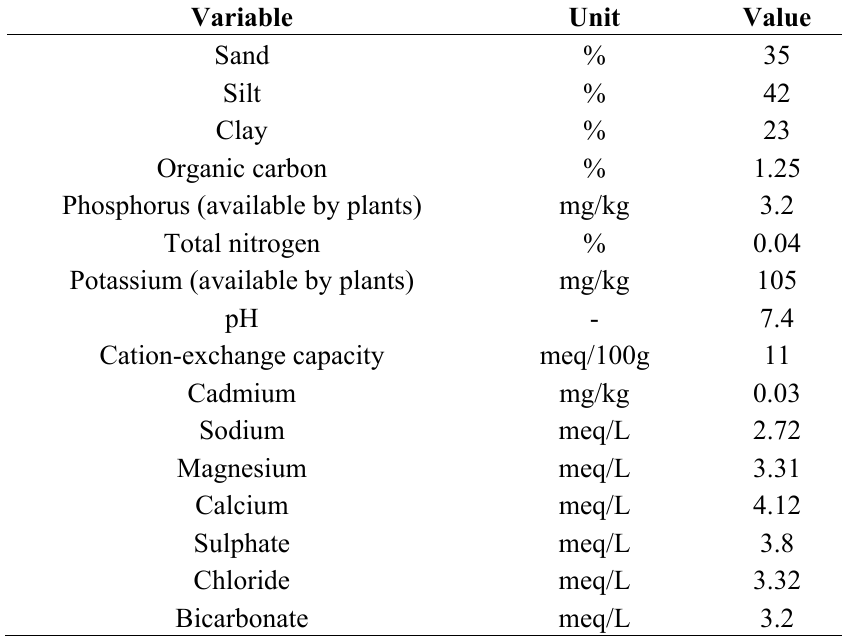
Table 2. Physical and chemical characteristics of soil samples (meq/L, milliequivalent of solute per